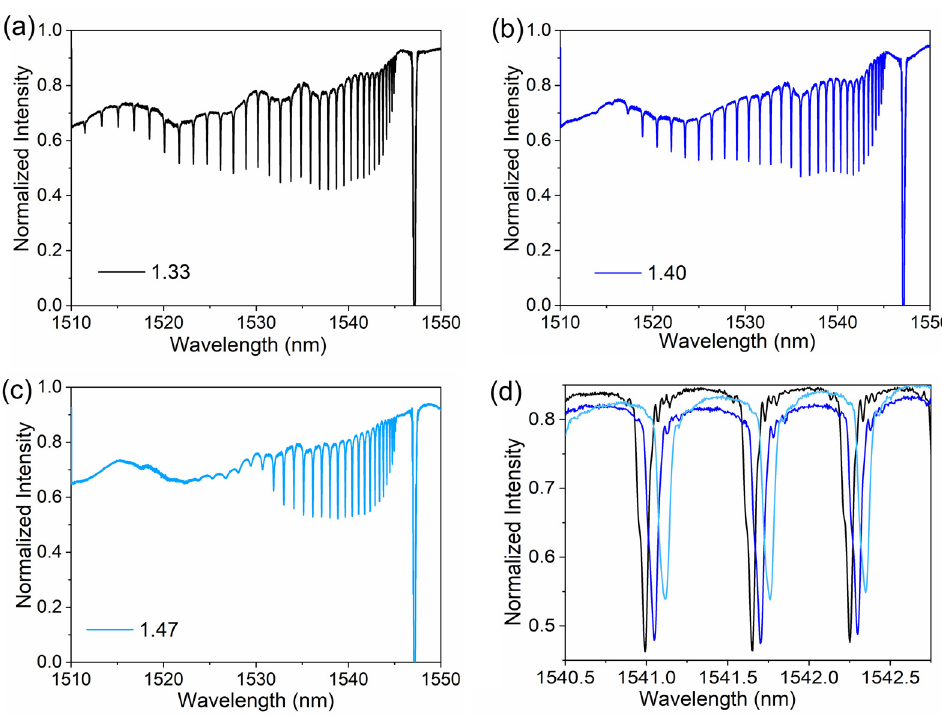
Figure 3. Experimental transmission spectra through a high-reflectivity FBG in the RI of 1.33 ( a ), 1.40 ( b ), and 1.47 ( c ). ( d ) Enlarged drawing of the narrow FWHM of the FBG sensor.